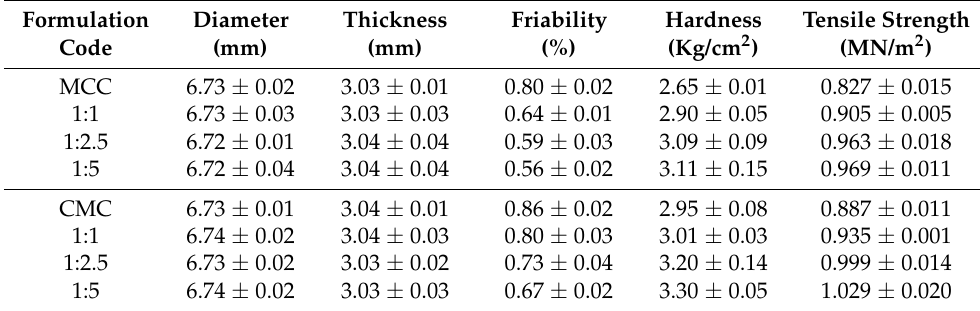
Table 6. Values depicting the size, friability, hardness and tensile strength of MCC and prepared MCC-SiO 2 FDTs in the ratio of 1:1, 1:2.5 and 1:5, Values depicting the size, friability, hardness and tensile strength of CMC and prepared CMC-SiO 2 FDTs in the ratio of 1:1, 1:2.5 and 1:5. Formulation